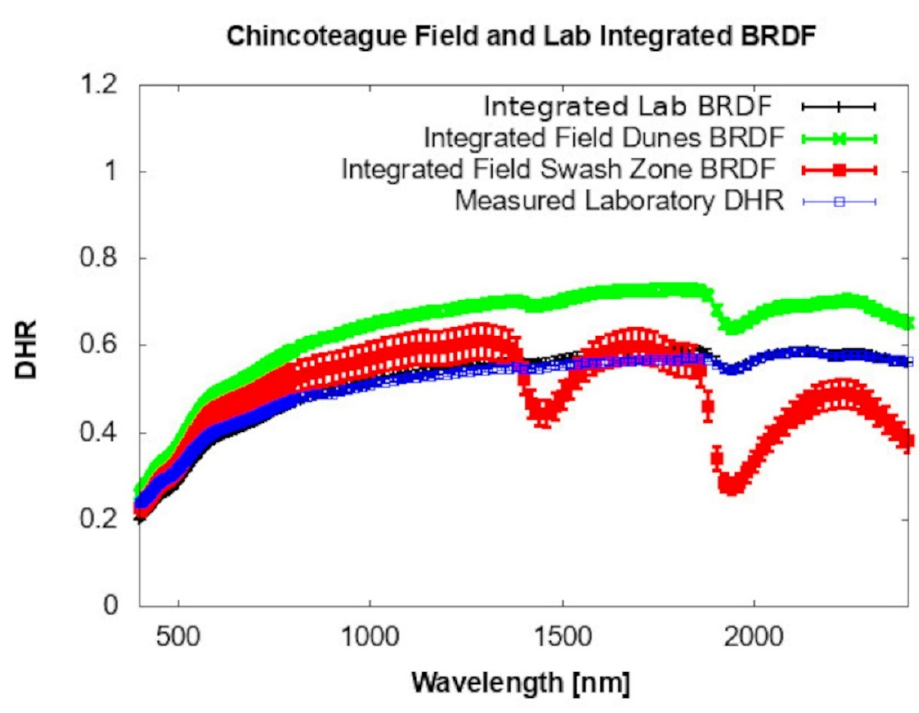
Figure 6. Shown are data taken on Chincoteague Island beach sand: Extracted DHR from laboratory (black), field dunes (green) and field swash zone (red) BRDF data. Laboratory measured DHR (blue) are identical within the measured error with the integrated laboratory BRDF results.